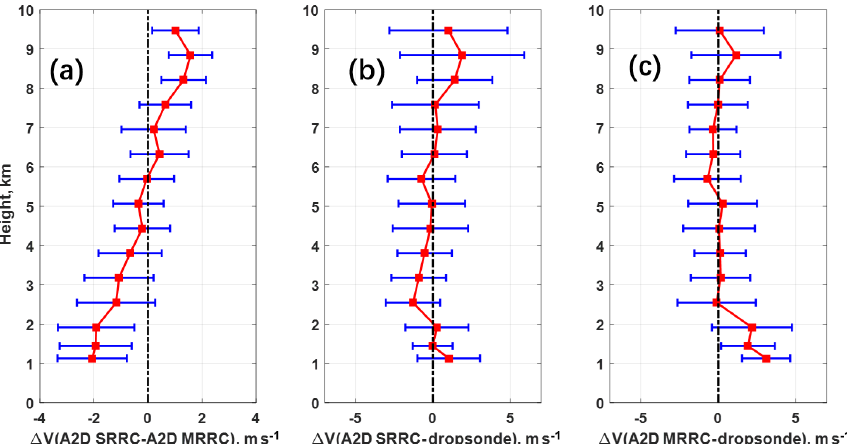
Figure 12. Comparison of profiles for LOS velocity (a) between A2D SRRC and MRRC, (b) SRRC and dropsonde, and (c) MRRC and